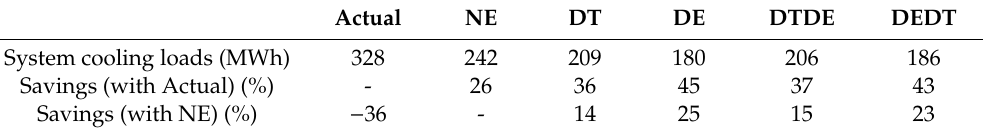
Table 5. Total system cooling loads and estimated energy savings of economizer control types. Actual NE DT DE DTDE